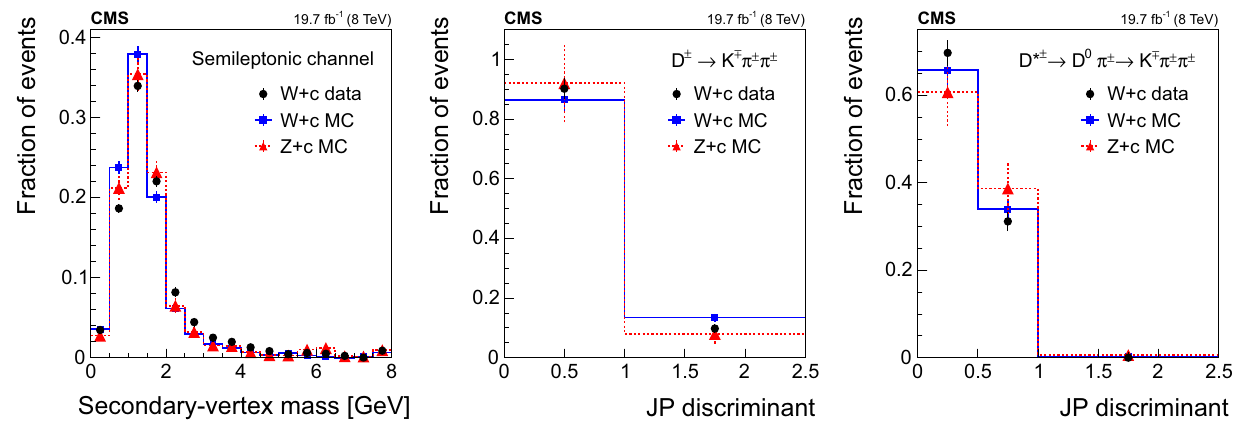
Fig. 5 Distributions of the corrected secondary-vertex mass (left plot) and JP discriminant (D ± and D ∗ ( 2010 ) ± modes in the middle and right plots), normalized to unity, in simulated W + c and Z + c samples, and in W + c data events. The W + c distributions are presented after the